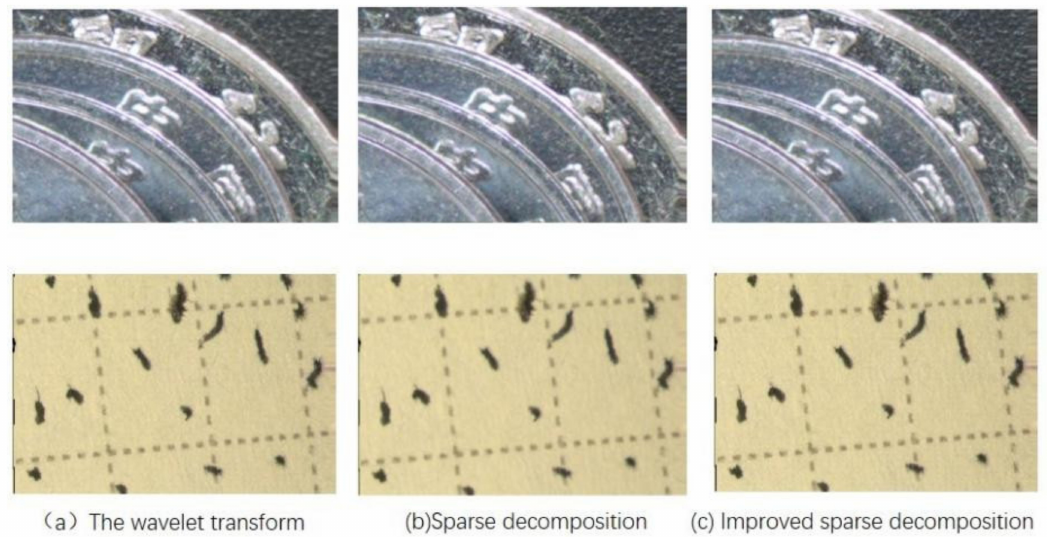
Figure 5. Fusion results of each